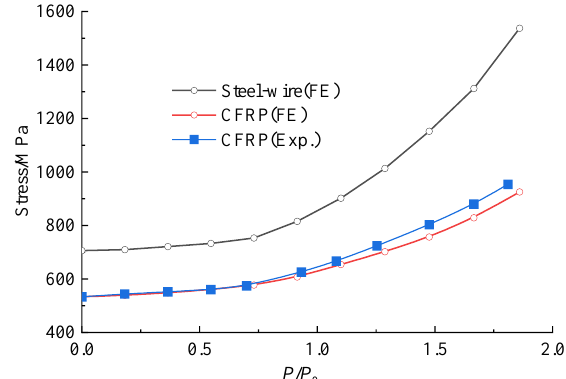
Figure 16. Stresses of prestressed CFRP plates and steel wire changed at different load level.